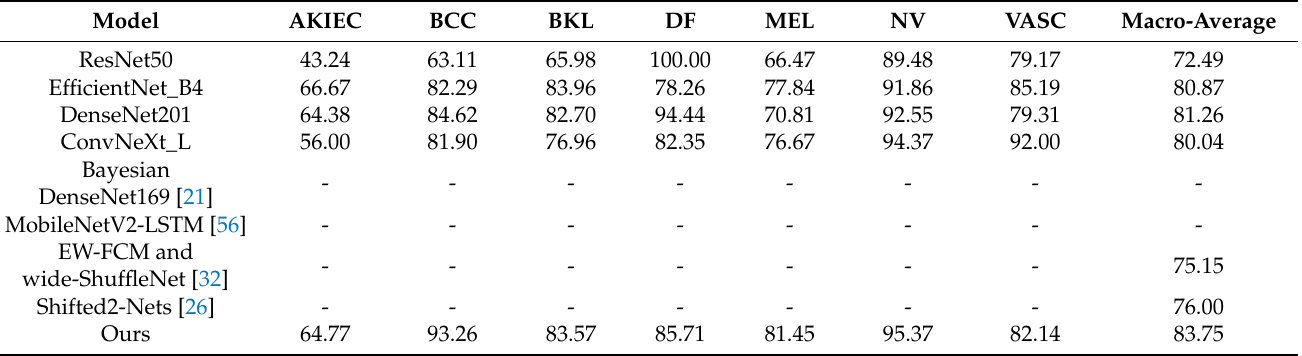
Table 10. The precision of each model on the public dataset HAM10000 (test set of 2000 images); the missing values of indicators are replaced by “-”, and the unit is %.